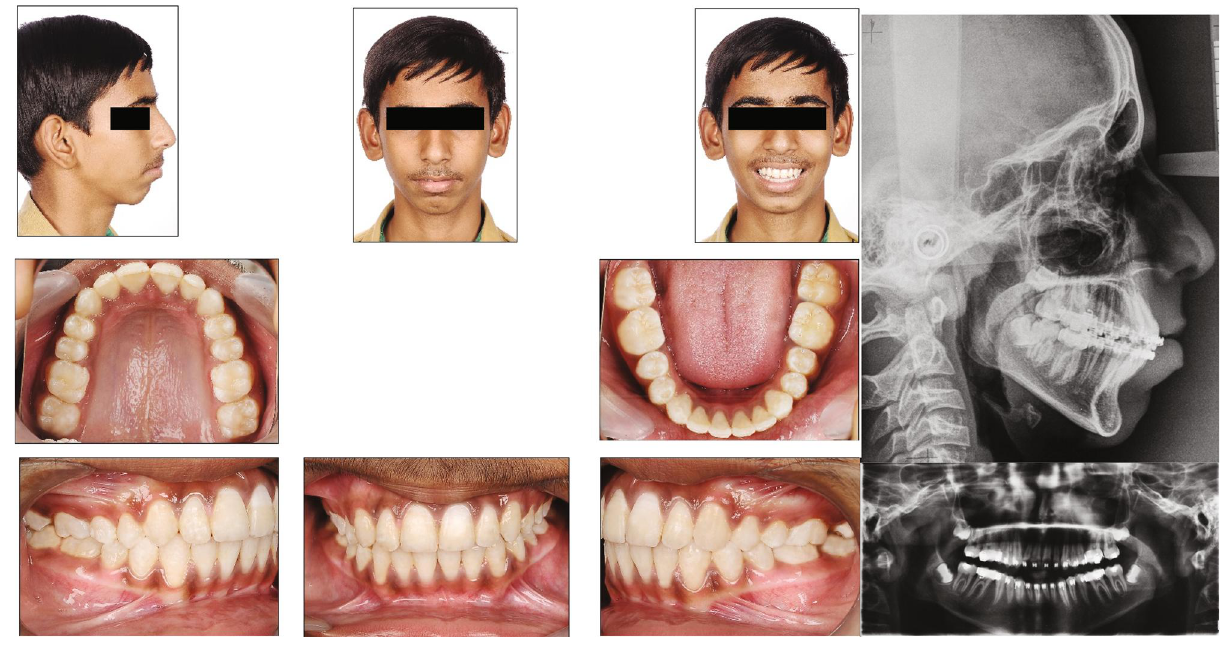
Figure 4: Posttreatment photographs and